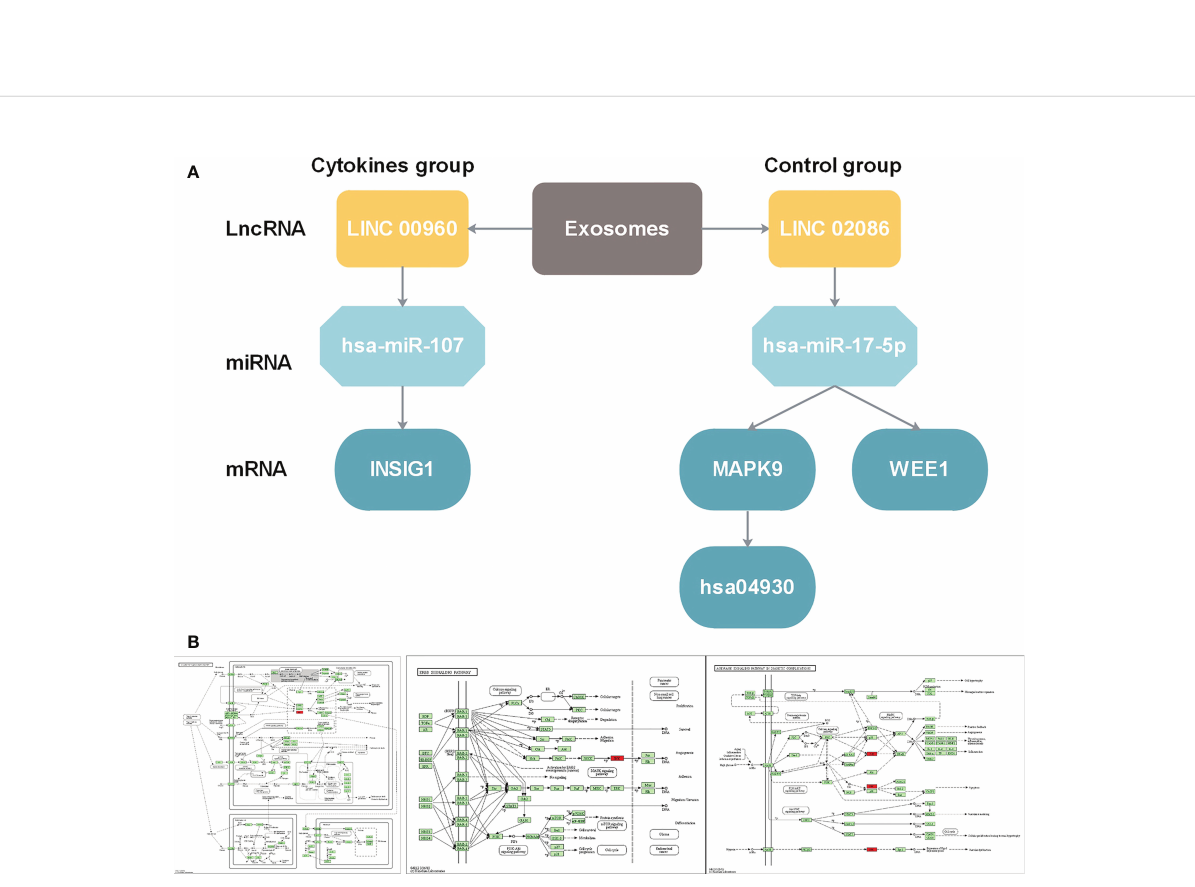
FIGURE 7 (A) LncRNA-miRNA-gene regulation cascades for lncRNA LINC00960 in state after exosome stimulation and for lncRNA LINC02086. (B) Function annotation for MAPK9 in KEGG pathways. From left to right: Diabetic cardiomyopathy pathway (hsa05415)(https://www.kegg.jp/ kegg-bin/show_pathway?16584585919469/hsa05415.args; ErbB signaling pathway (hsa04012) (https://www.kegg.jp/kegg-bin/show_pathway? 16584585919469/hsa04012.args); AGE-RAGE signaling pathway in diabetic complications (hsa04933) (https://www.kegg.jp/kegg-bin/show_